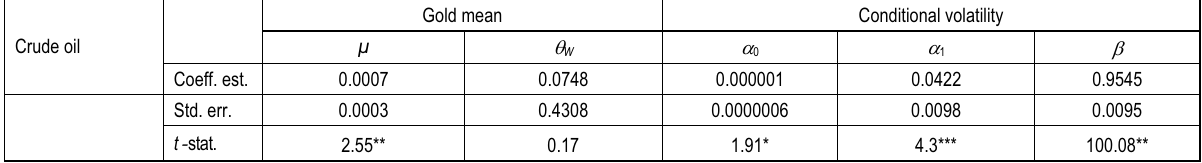
Table 9. Estimation results for